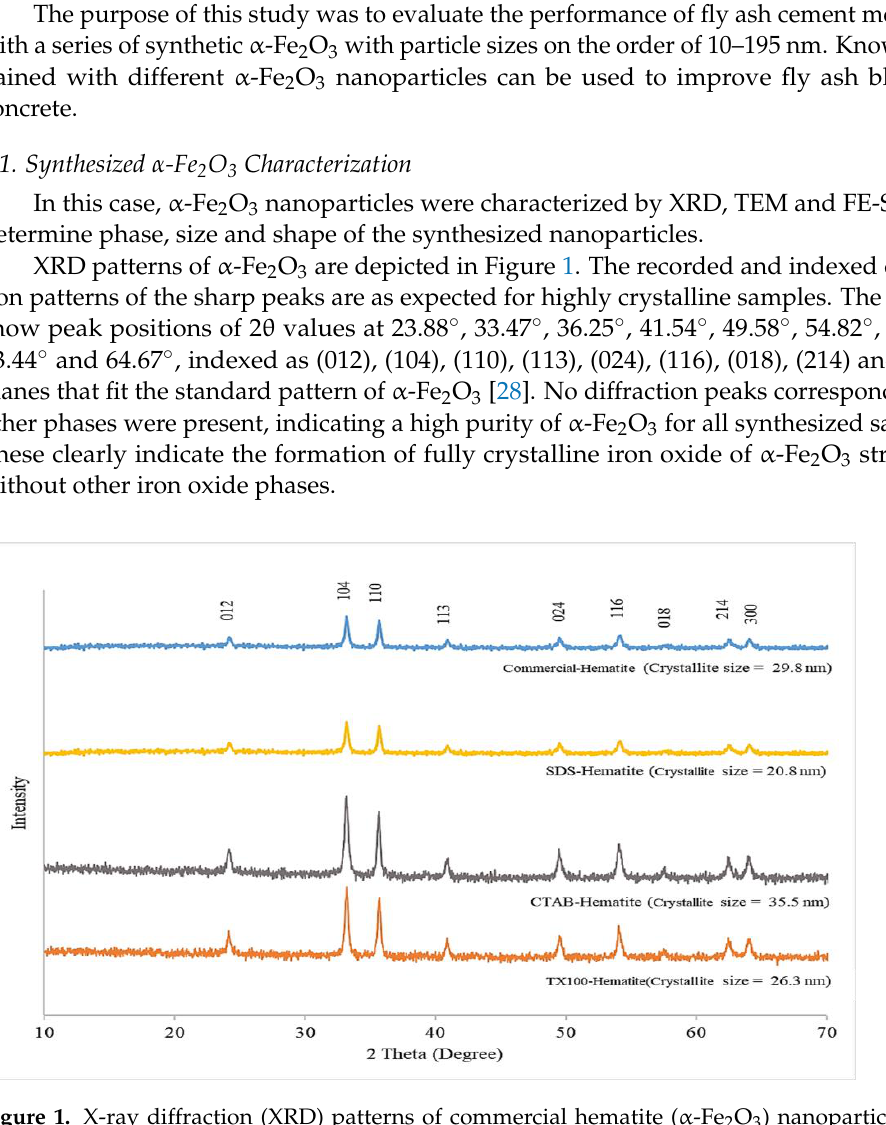
Figure 1. X-ray diffraction (XRD) patterns of commercial hematite (α-Fe 2 O 3 ) nanoparticles and α- Fe 2 O 3 nanoparticles synthesized using sodium dodecyl sulfate (SDS), cetyltrimethylammonium bromide (CTAB) and polyoxyethlyene tert-octylphenyl ether (TX100) as templates.